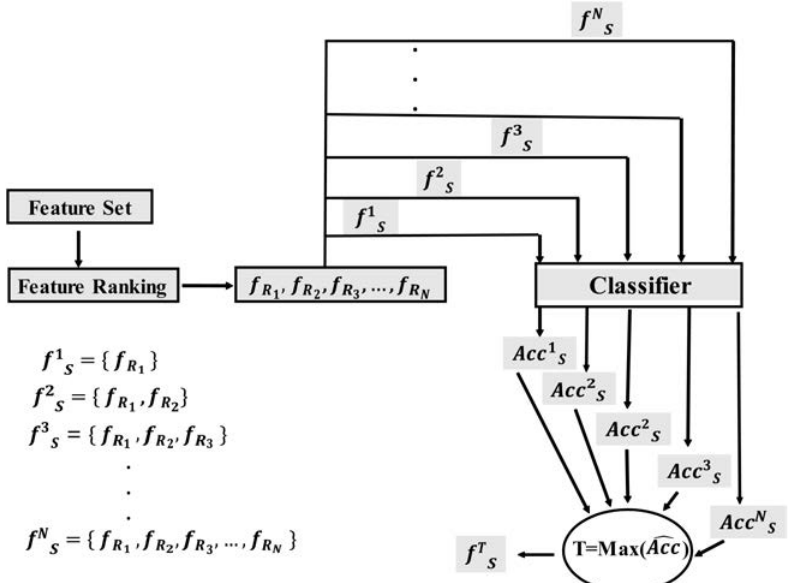
Fig. 13. Complete framework for optimal ranked features selection, where f N S represenets the total number of feature subsets acquired from ranked feature list, Acc N S denotes the classi¯cation accuracy corresponding to feature subset f N S , T represents the maximum accuracy obtained using a feature subset f T S